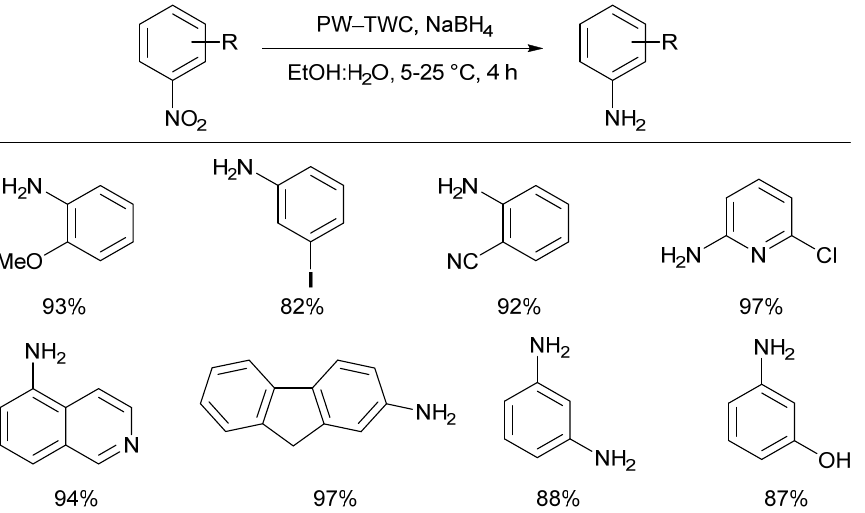
Figure 14. Application of three ‐ way catalyst (PW ‐ TWC) material applied directly in milled form as a catalyst for the reduction of nitroarenes, Reproduced with permission from [109].